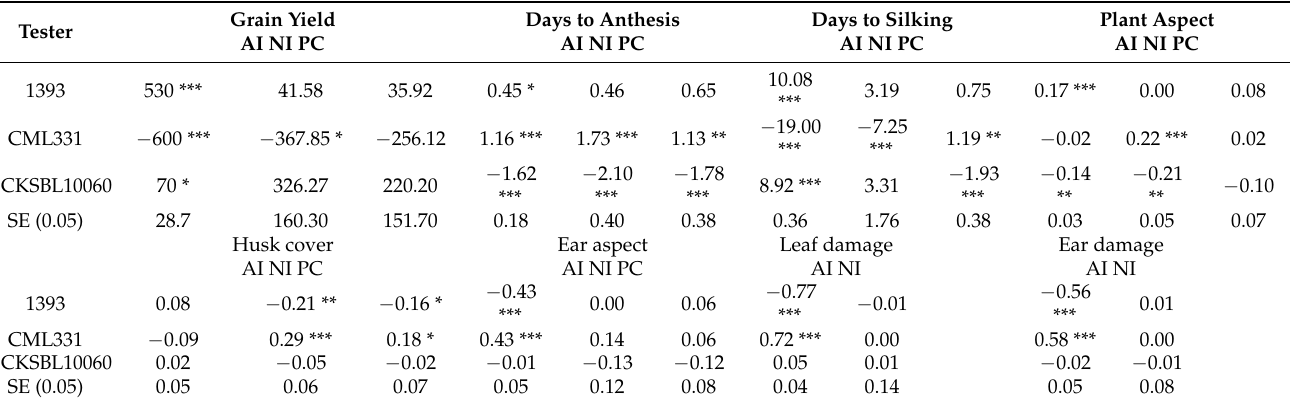
Table 4. General combining ability effect of testers for grain yield, agronomic and fall armyworm (FAW)-resistant traits under FAW infestation and pesticide-protected conditions in